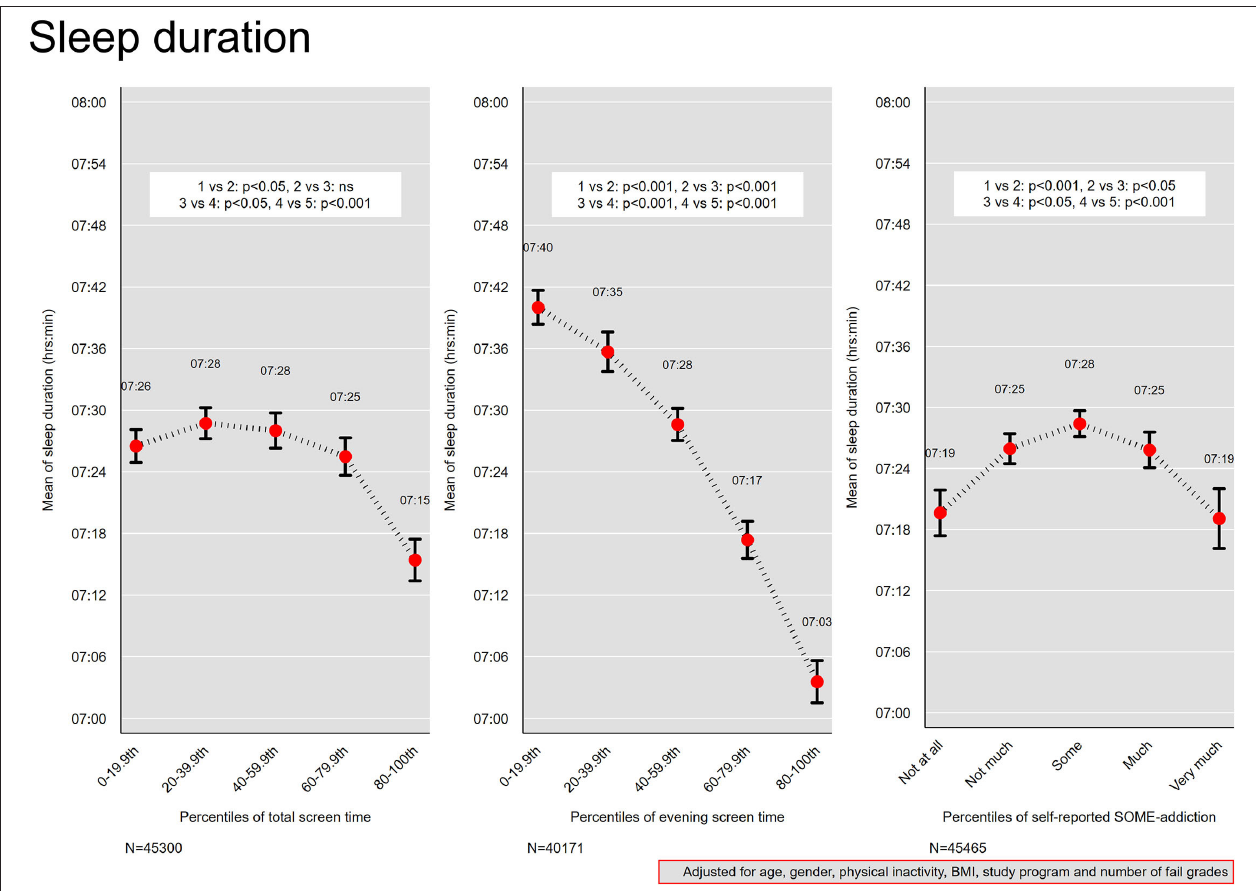
FIGURE 2 | Sleep duration. Mean sleep duration across quintiles of total screen time and evening screen time, and levels of self-reported social media addiction. Results from linear regression models adjusted for age, gender, physical activity, and body mass index. Bars denote 95 % confidence